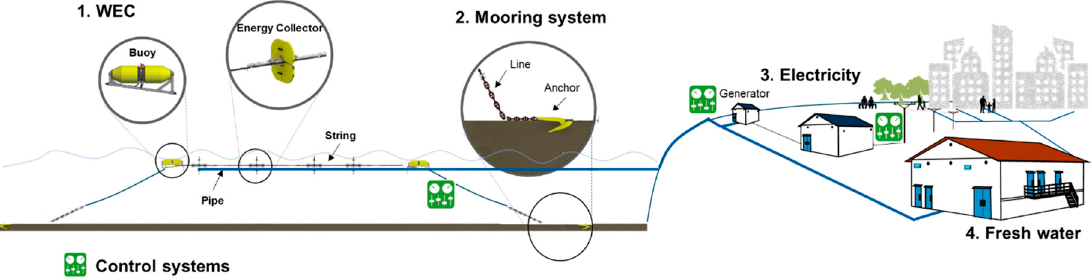
Figure 6. Demonstration W2EW smart grid